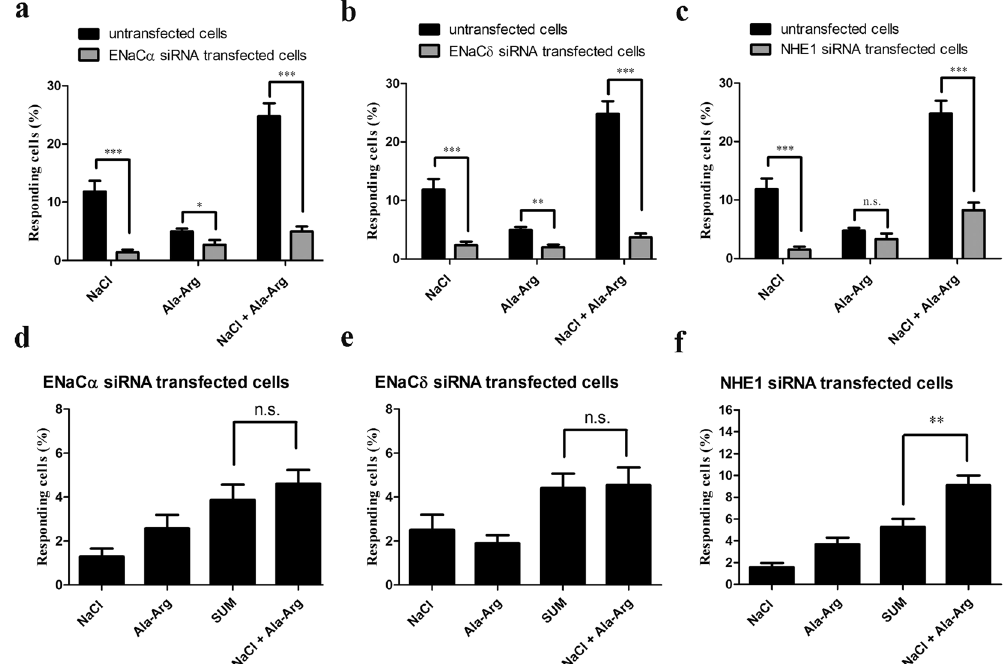
Figure 7. Signaling pathways of Ala-Arg (AR) in siRNA study. (a – c) NaCl (150 mM), AR (50 µ M), and the mixture of NaCl and AR elicited responses in both siRNA-transfected and untransfected cells. Each experiment was performed eleven times. (d – f) AR regulation of cellular responses to NaCl in siRNA-transfected cells. Each experiment was performed seventeen times. Cell responses were measured by intracellular Ca 2 + changes.